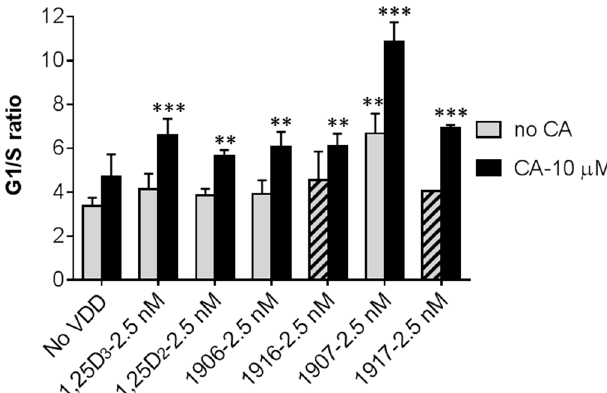
Figure 6. VDDs and CA cooperate in the inhibition of G1-to-S cell cycle transition in MOLM-13 cells. Cells were treated with the indicated concentrations of VDDs and CA, alone and in combination, for 48 h. The cellular DNA content was then determined by propidium iodide staining using flow cytometry. Hatched columns indicate the effects of the 24 Z analogs added alone. The data are the means ± SD ( n = 3). **, p < 0.01; and ***, p < 0.001 vs. untreated control.